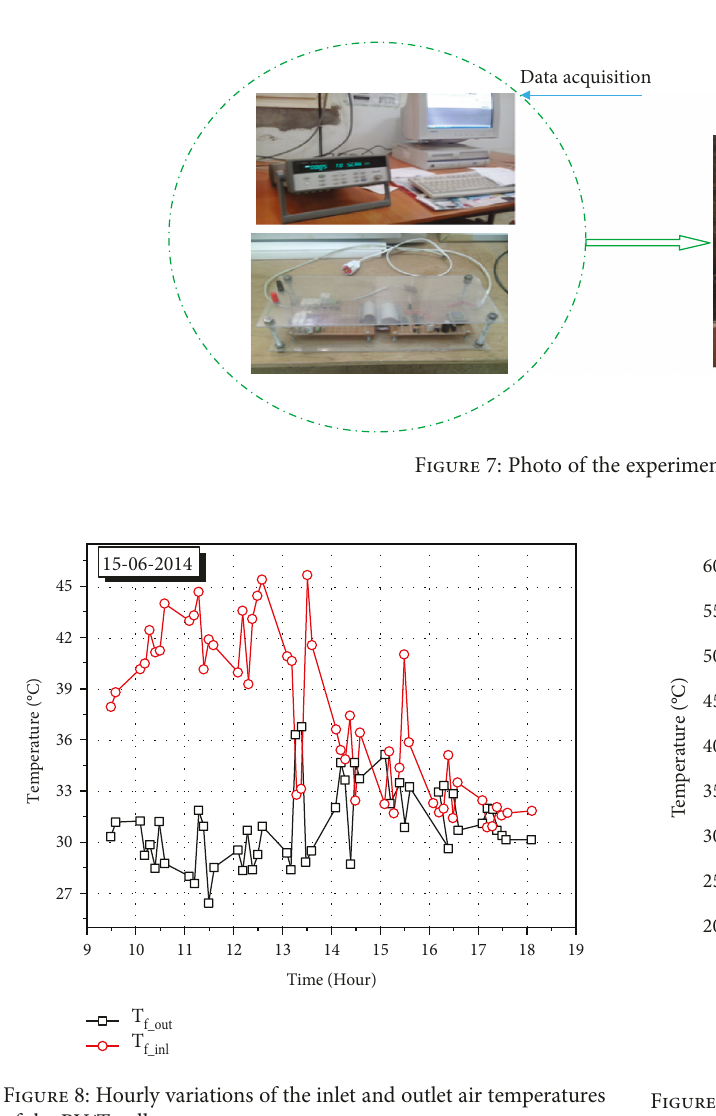
Figure 9: Hourly variation of the temperature elements of the